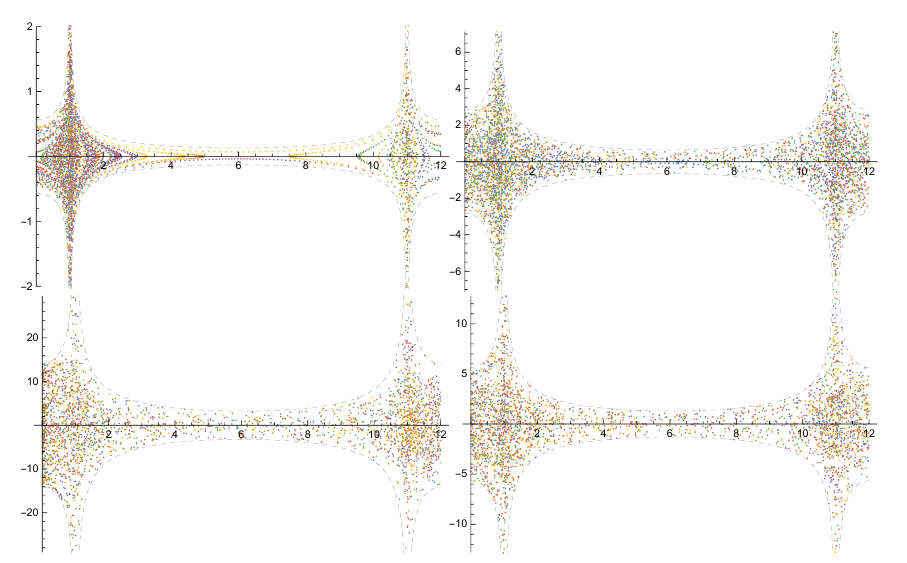
Figure 7 . Power spectra associated to the trajectories shown in (cid:12)gure 6. Left we have E = 0 : 05 with a see a comparatively clean spectrum and on the right E = 5 : 0.